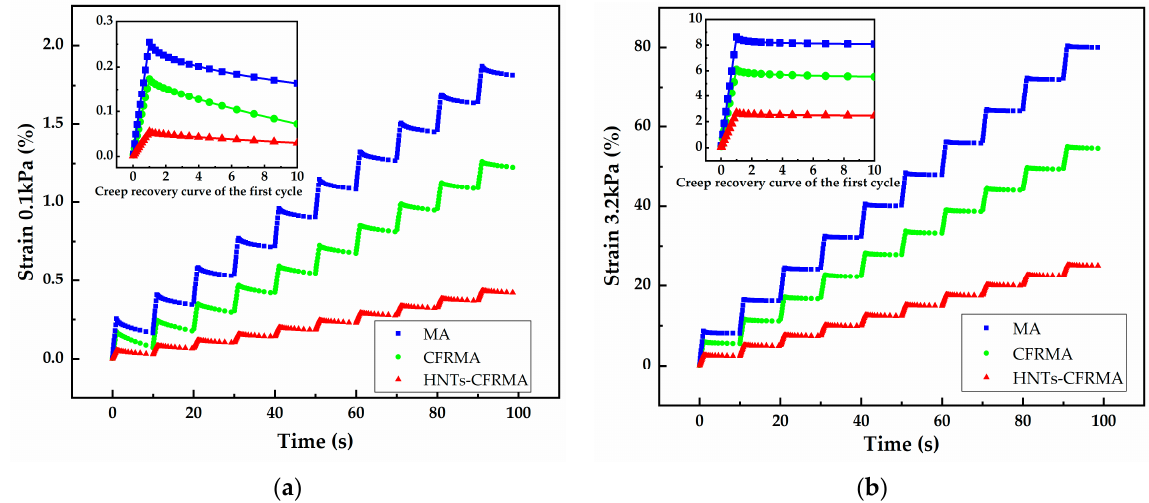
Figure 8. Characterization of flame retardant asphalt MSCR high temperature performance: ( a ) 0.1 kPa asphalt 10-cycle creep behavior curve; and ( b ) 3.2 kPa asphalt 10-cycle creep behavior curve.